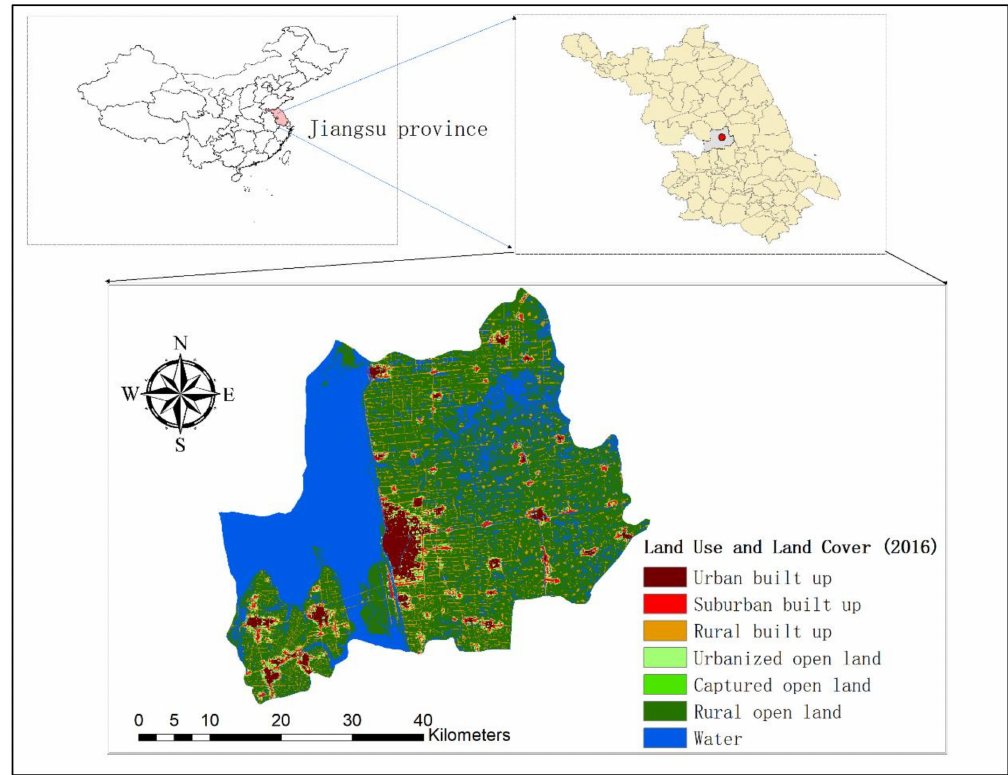
Figure 1. Location of Gaoyou city, in Jiangsu province. Coverage of green areas as well as its rich resources in developing